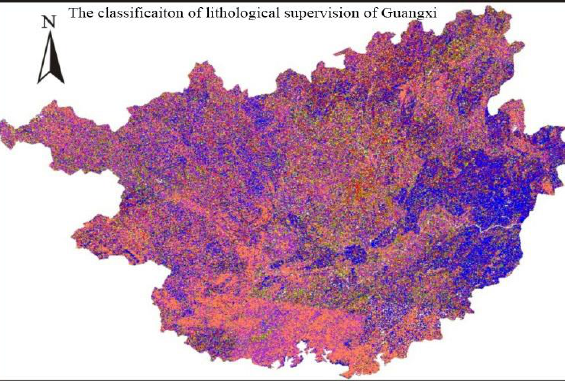
Figure 2. Classification of lithological supervision (Tao, 2013)